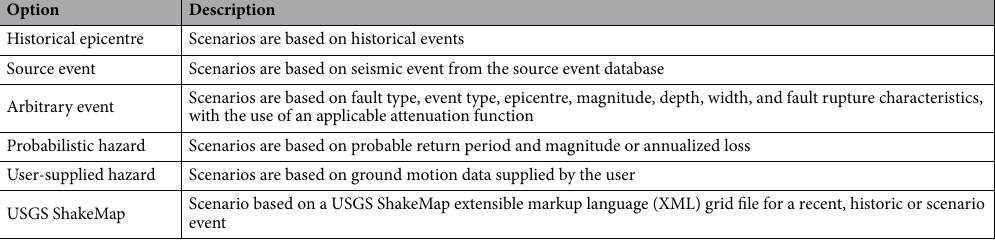
Table 2. Options for defining an earthquake module.